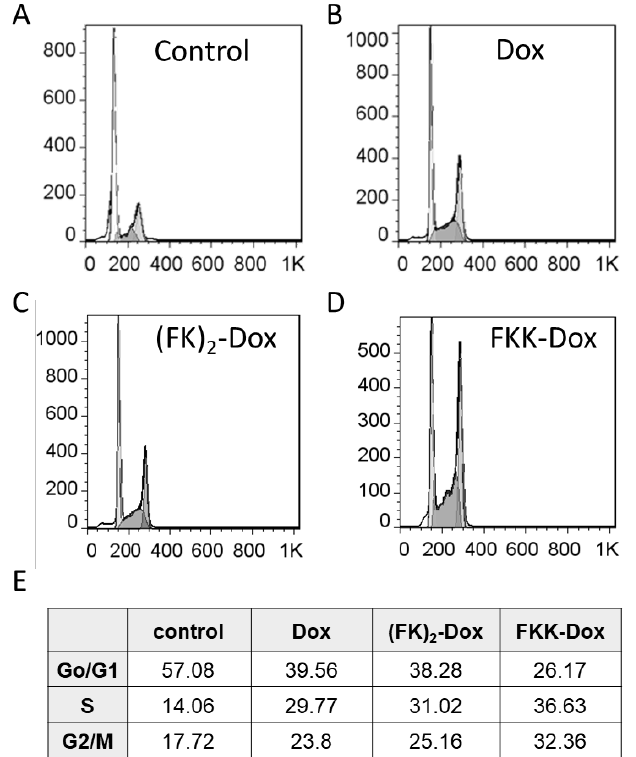
Figure 8. ( A – D ) Cell cycle distribution analysis. Hela cells were treated with free Dox (100 nM), (FK) 2 -Dox (100 nM of Dox) or FKK-Dox (100 nM of Dox) and analyzed at 24 h after the treatment. Raw data for a representative experiment is shown. ( B ) Quantitative analysis of cell cycle distribution based on Figure 8 A – D .